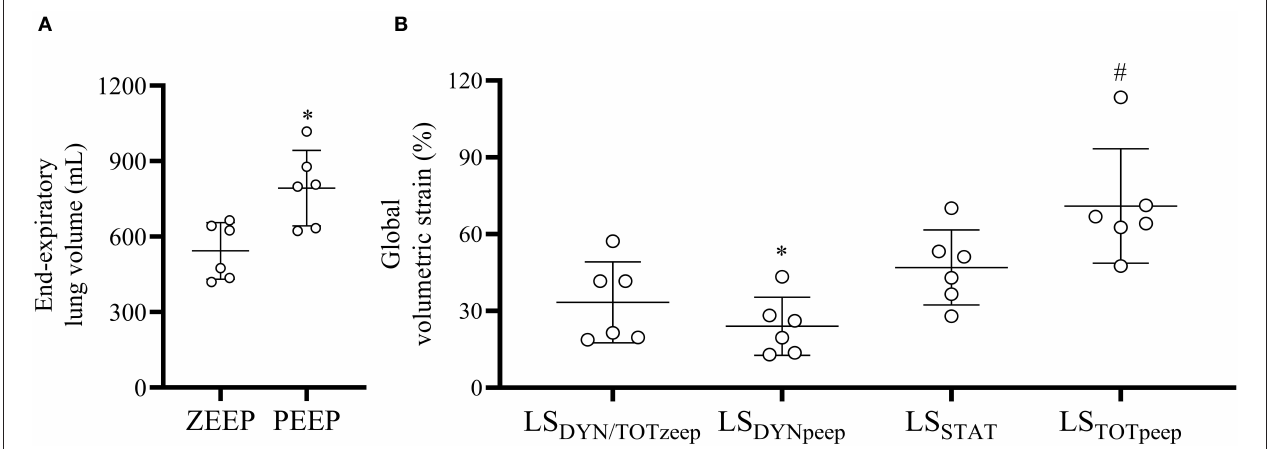
FIGURE 4 | End-expiratory lung volume and global volumetric strain during ZEEP and PEEP. (A) End-expiratory lung volume increased significantly with PEEP. * p < 0.001 compared with ZEEP, (B) PEEP significantly reduced the dynamic (LS DYNpeep ) compared with PEEP (LS DYNzeep ) and increased the total global volumetric strain (LS TOTpeep ) compared with ZEEP (LS TOTzeep , assumed to be the same as LS DYNzeep ). * p < 0.001 compared with LS DYNzeep , # p = 0.005 LS TOTpeep compared with LS TOTzeep .